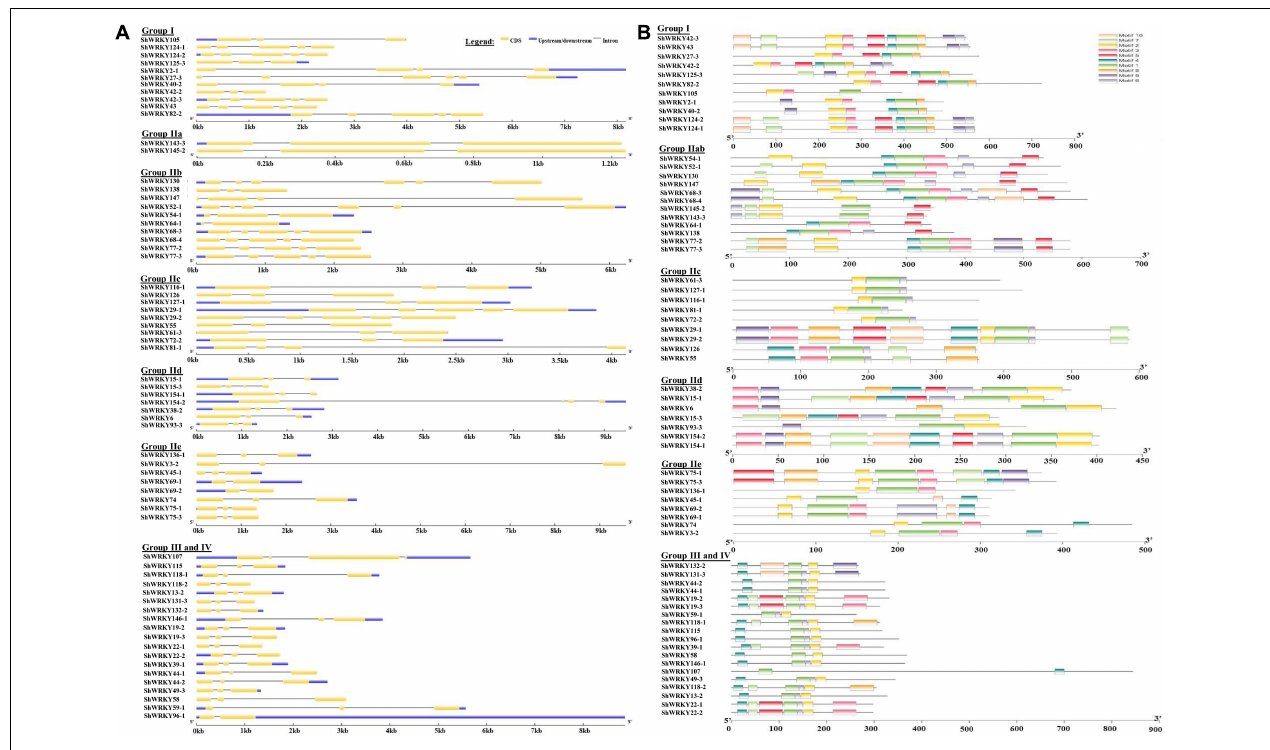
FIGURE 2 | (A) Locations and lengths of ShWRKY exons and introns which are shown as filled yellow bars and thin gray single lines, respectively. UTRs are represented by dark blue bars at the ends of the lines. Gene structures were drawn using the GSDS online database. (B) Conserved motif analysis of ShWRKYs . All motifs were identified using the MEME online database and visualized with Tbtools software. A total of ten predicted motifs are represented by different colored boxes and motif sizes can be estimated using the scale at the bottom.